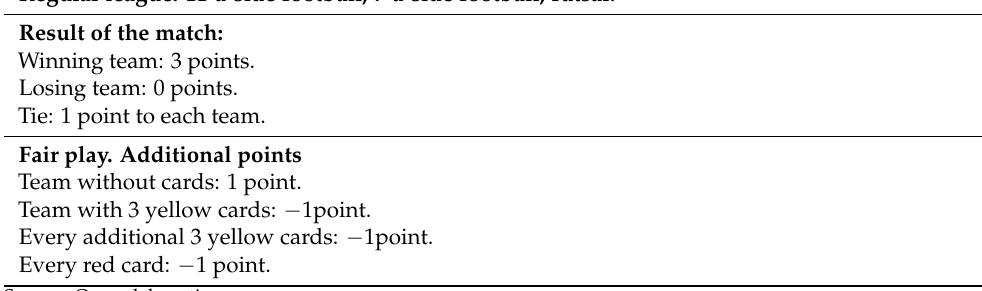
Table 1. Rules in the regular